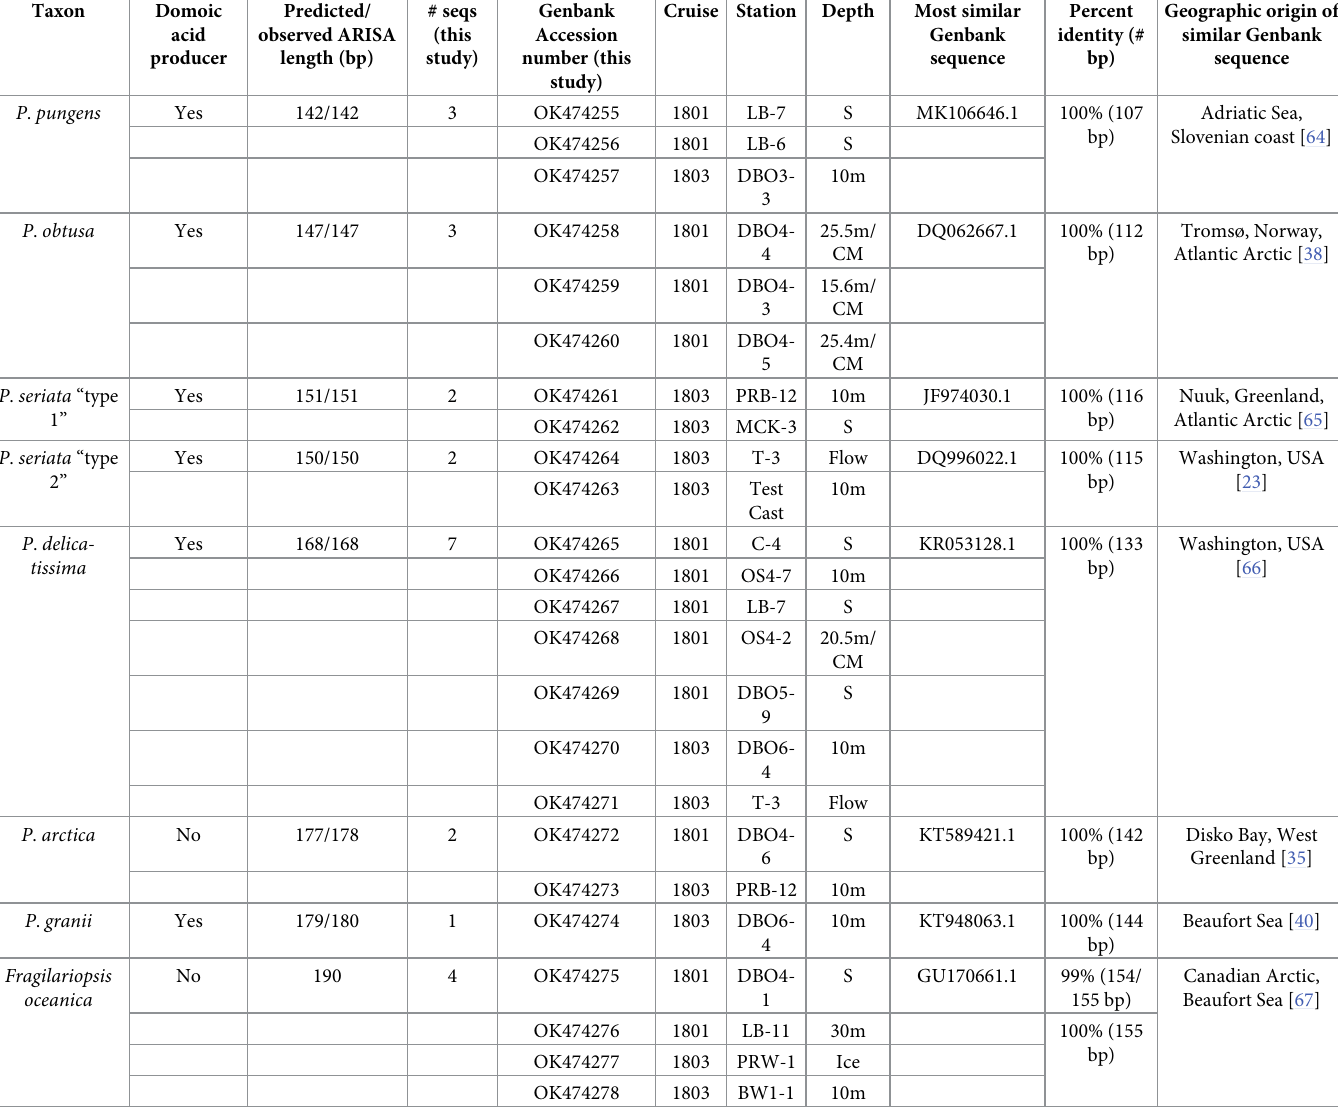
Table 3. Summary of species and sequences generated and used for identification of ARISA sizes in summer ( Healy 1801) and fall ( Healy 1803) samples.